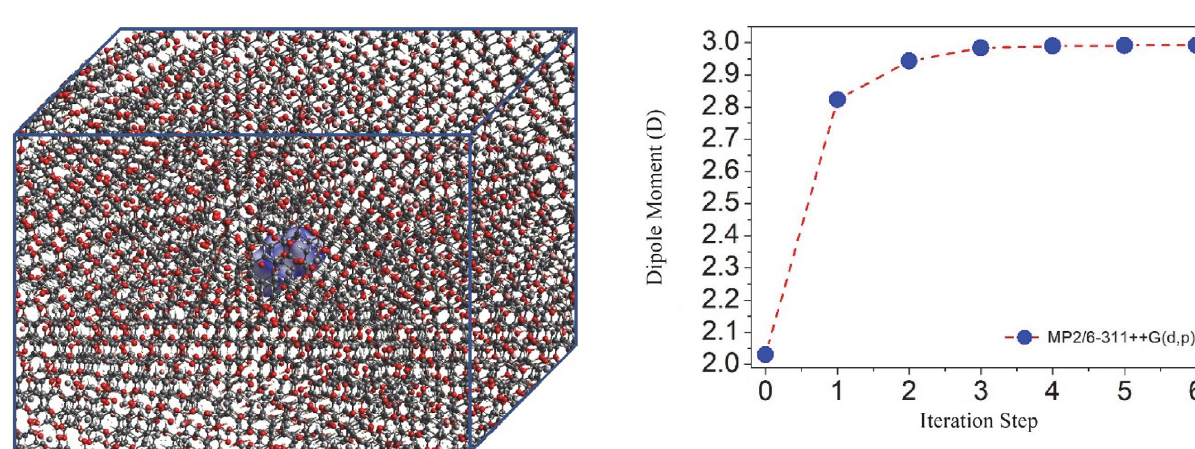
Figure 2: A schematic of the bulk is displayed.